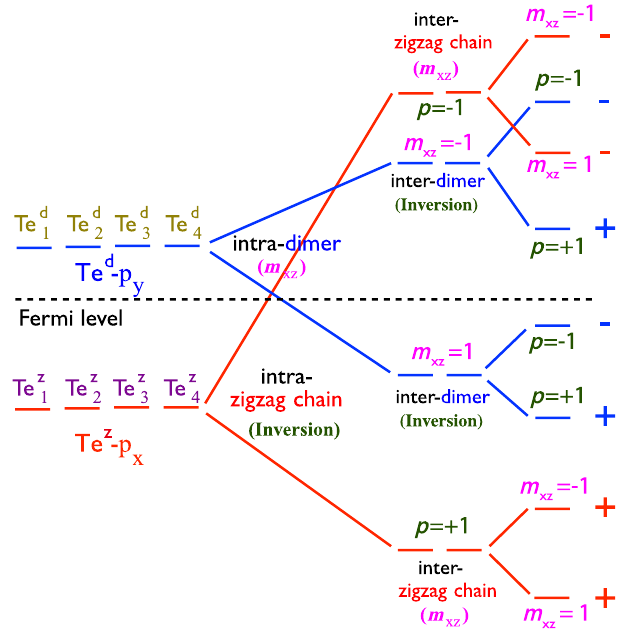
FIG. 4 (color online). The schematic illustration of the band inversion mechanism (see main text for details).